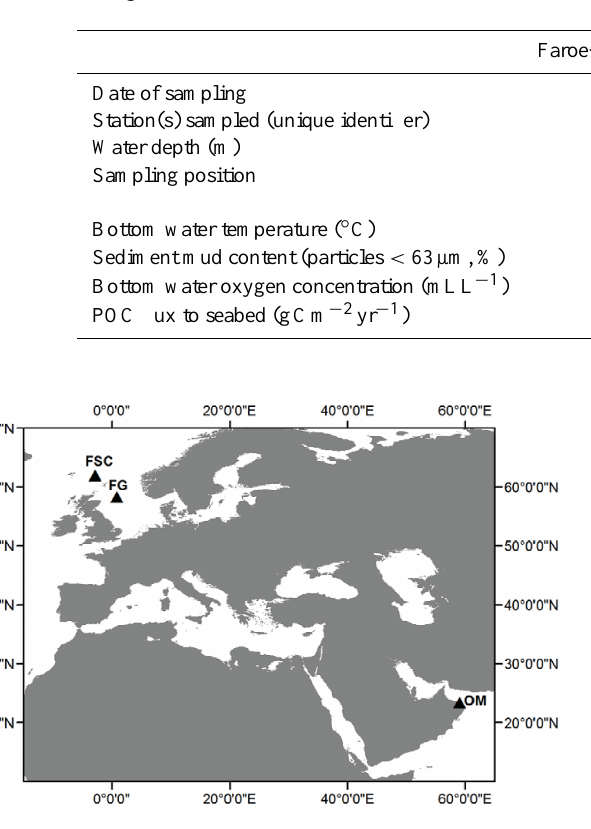
Figure 1. Chart showing the locations of the three study sites: Fladen Ground (FG), Faroe–Shetland Channel (FSC), and Oman Margin